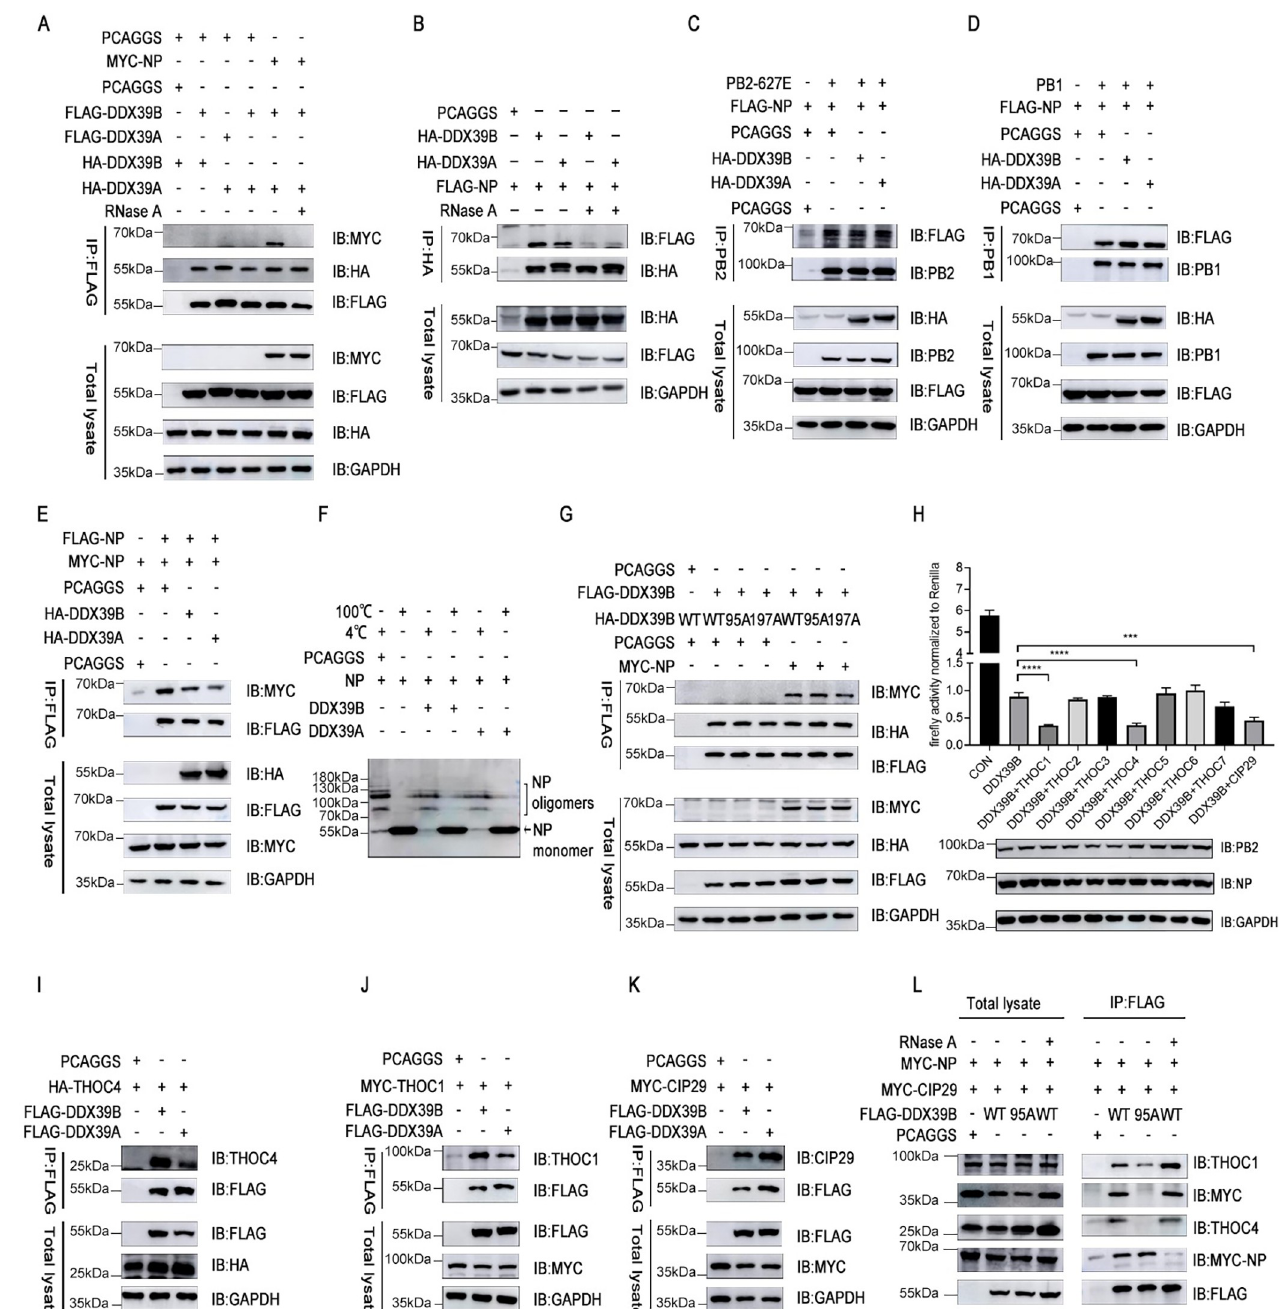
Fig 6. Effects of DDX39B and DDX39A on polymerase activity depend on ATP to recruit TREX complex subunits THOC1, THOC4 and CIP29. (A) HEK293T cells were co-transfected with HA-DDX39B or FLAG-DDX39B, HA-DDX39A or FLAG-DDX39A, MYC-NP or empty pCAGGS vectors, at 48h after transfection, the cells were lysed treated with or without RNase A, followed by co-IP with anti-FLAG mouse Mab. (B) HEK293T cells were co-transfected with FLAG-NP and HA-DDX39B, HA-DDX39A or empty pCAGGS vectors, at 48h after transfection, the cells were lysed and treated with or without RNase A, followed by co-IP with anti-HA mouse Mab. (C) HEK293T cells were co-transfected with FLAG-NP and PB2 together with HA-DDX39B, HA-DDX39A or empty pCAGGS vectors, at 48h after transfection, the cells were lysed, followed by co-IP with anti-PB2 mouse Mab. (D) HEK293T cells were co-transfected with FLAG-NP and PB1 together with HA-DDX39B, HA-DDX39A or empty pCAGGS vectors, at 48h after transfection, the cells were lysed, followed by co-IP with anti-PB1 mouse Mab. (E) HEK293T cells were co-transfected with FlAG-NP and MYC-NP together with HA-DDX39B, HA-DDX39A or empty pCAGGS vectors, at 48h after transfection, the cells were lysed, followed by co-IP with anti-FLAG mouse Mab. (F) HEK293T cells were co-transfected with NP and HA-DDX39B or HA-DDX39A, at 24h after transfection, the cells were lysed and cell lysates were divided into 2 portions: stored at 4˚C or heated at 100˚C for 5